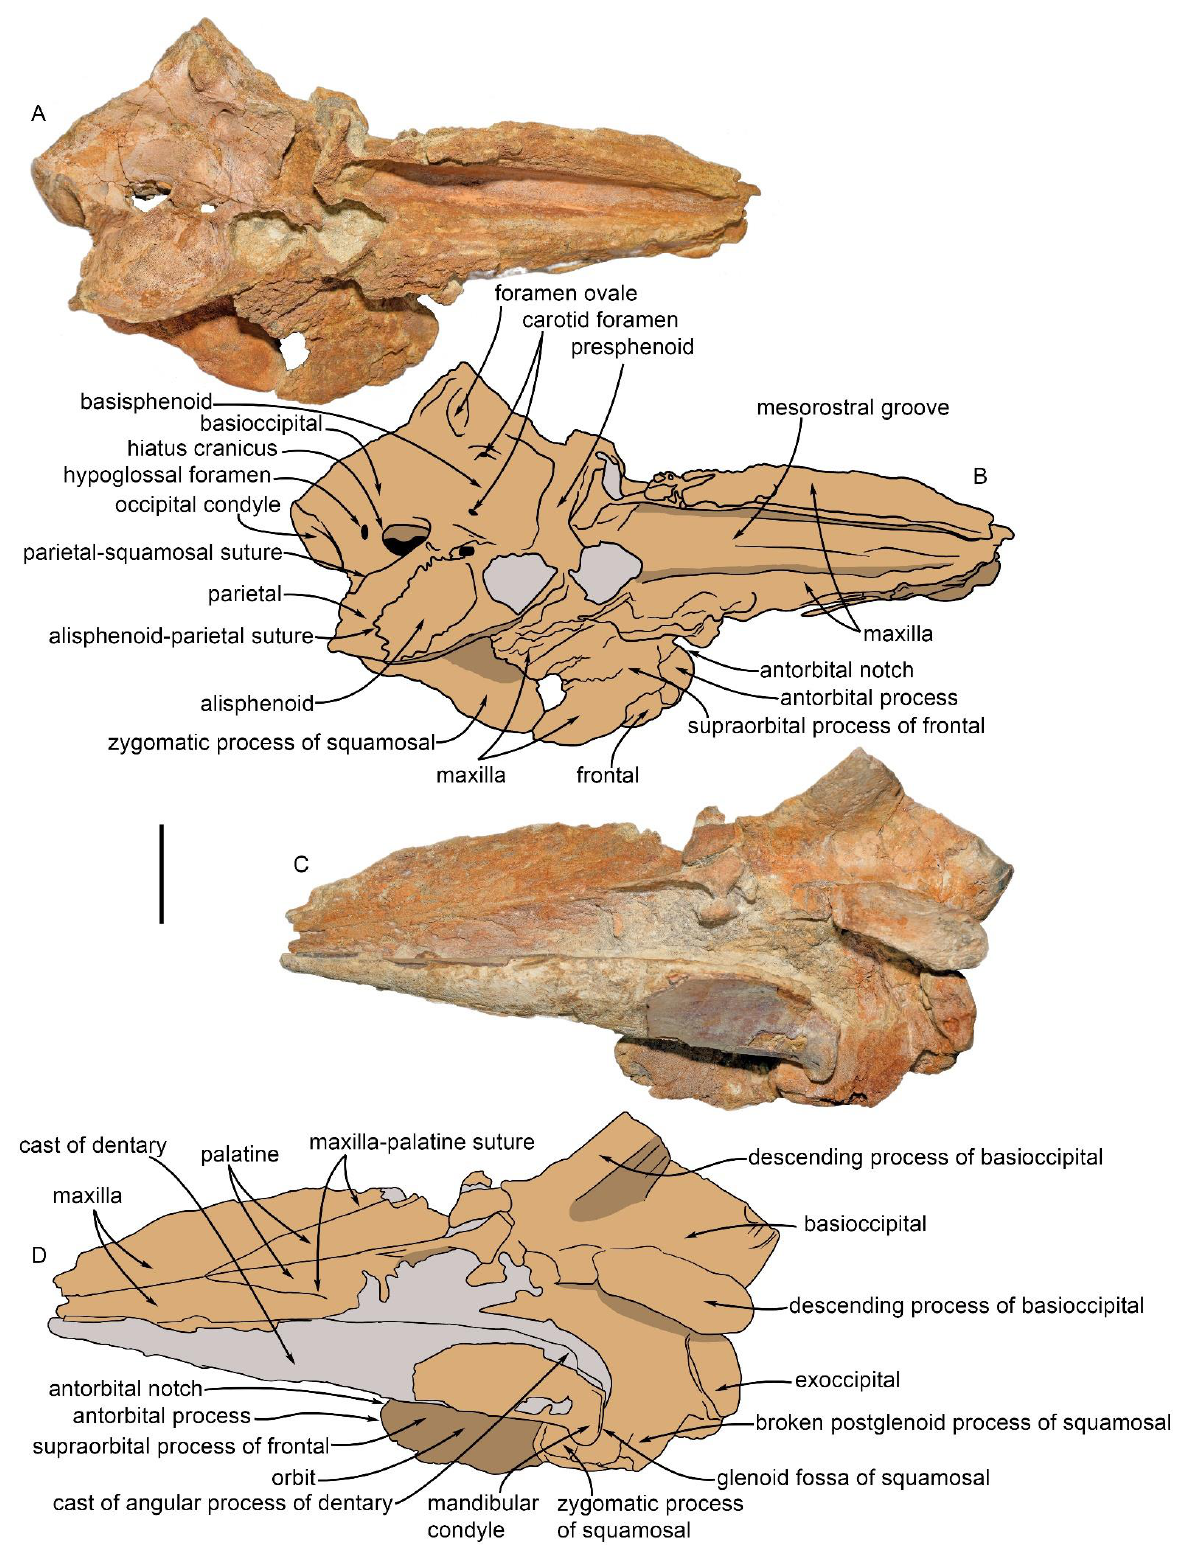
Figure 4. The partial skull MGPT-PU 13881/1 after preparation. ( A ) photographic representation of the skull in dorsal view. ( B ) Anatomical interpretation of ( A ). ( C ) Photographic representation of the skull in ventral view. ( D ) Anatomical interpretation of ( C ) Scale bar equals 5 cm.